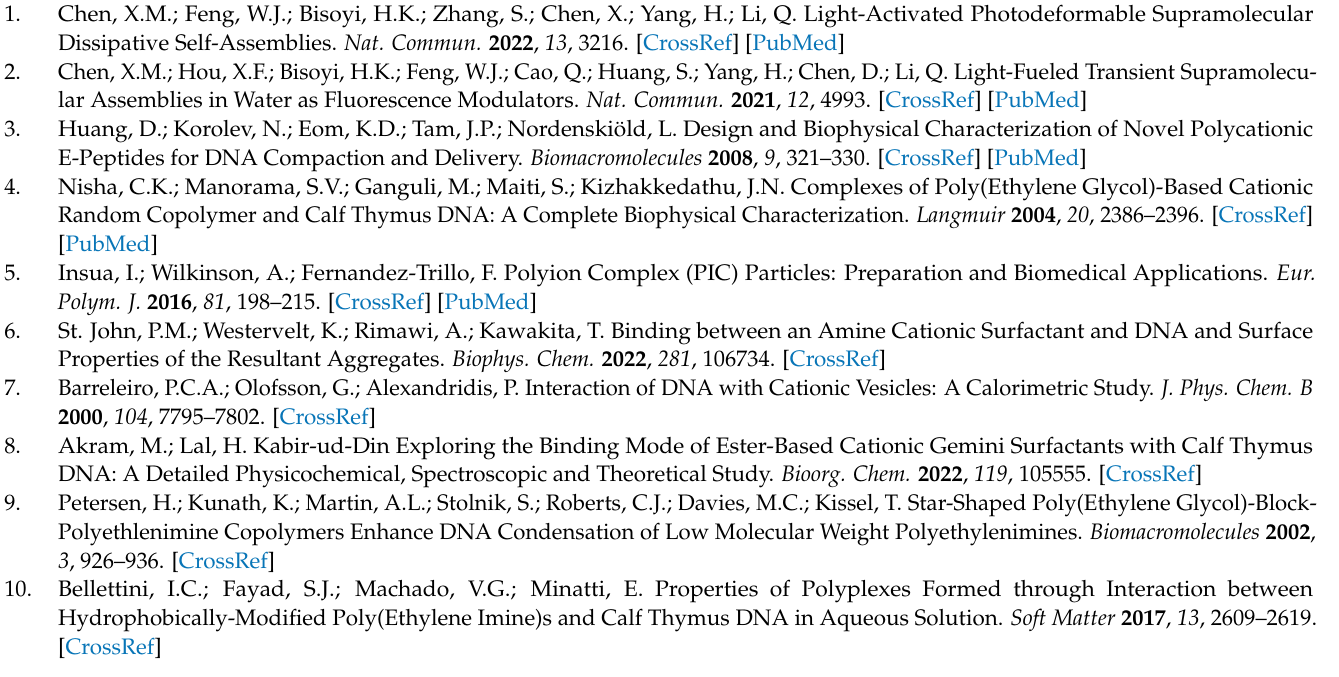
Table S1: Mass of reactants used in the synthesis of copolymers (PTEA) 50 - b -(PAm) 50 , (PTEA) 50 - b -(PAm) 200 , and (PTEA) 50 - b -(PAm) 1000